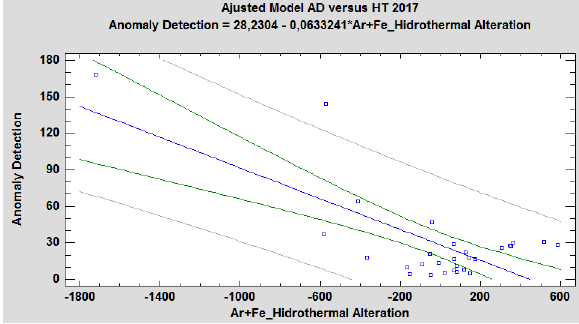
Figure 6. Correlation fit model example Anomaly Detection vs Hydrothermal Alteration for 2017.